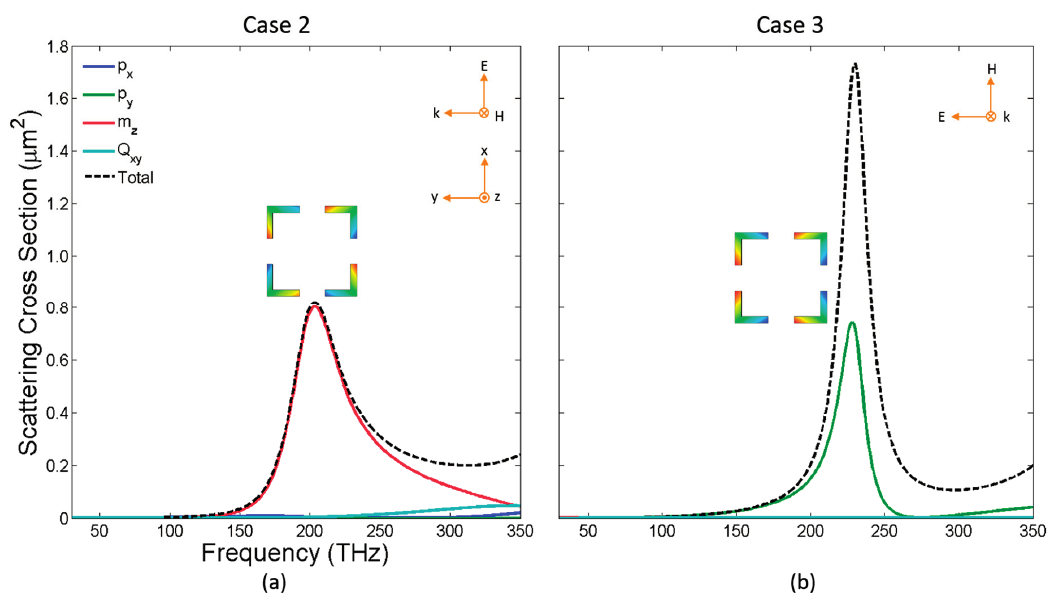
Figure 5. Multipolar decomposition of the scattering cross-section, for a 4-SRR between 30 THz and 350 THz, into the lowest order multipoles; ( a ) Case 2: electric field in-plane, magnetic field out-of-plane; one resonance is observed at f 1 = 203 THz. Strong magnetic , excitation is observed. ( b ) Case 3: electric and magnetic fields in-plane; one dipole, (cid:1865) (cid:3053) , excitation is observed. resonance is observed at f 2 = 230 THz. Only electric dipole, (cid:1868) (cid:3052) Insets show the real part of (cid:1831) at the corresponding resonance frequencies using a rainbow (cid:3053) colormap (min in blue, zero in green, and max in